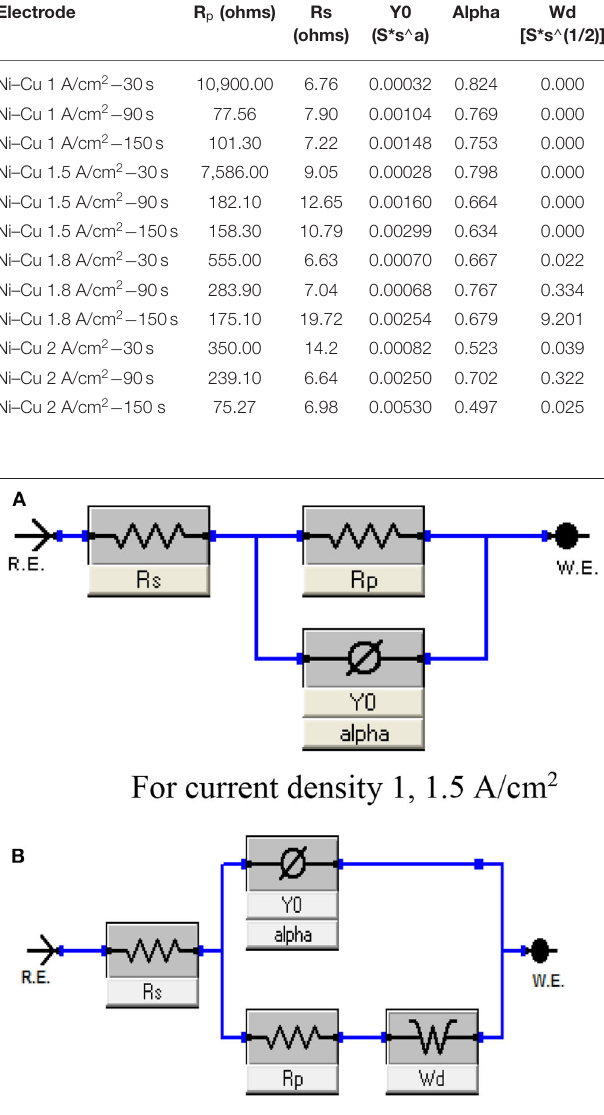
TABLE 5 | Impedance data for electrodeposited Ni/Cu foams in 1M KOH at 25 ◦ C. Electrode